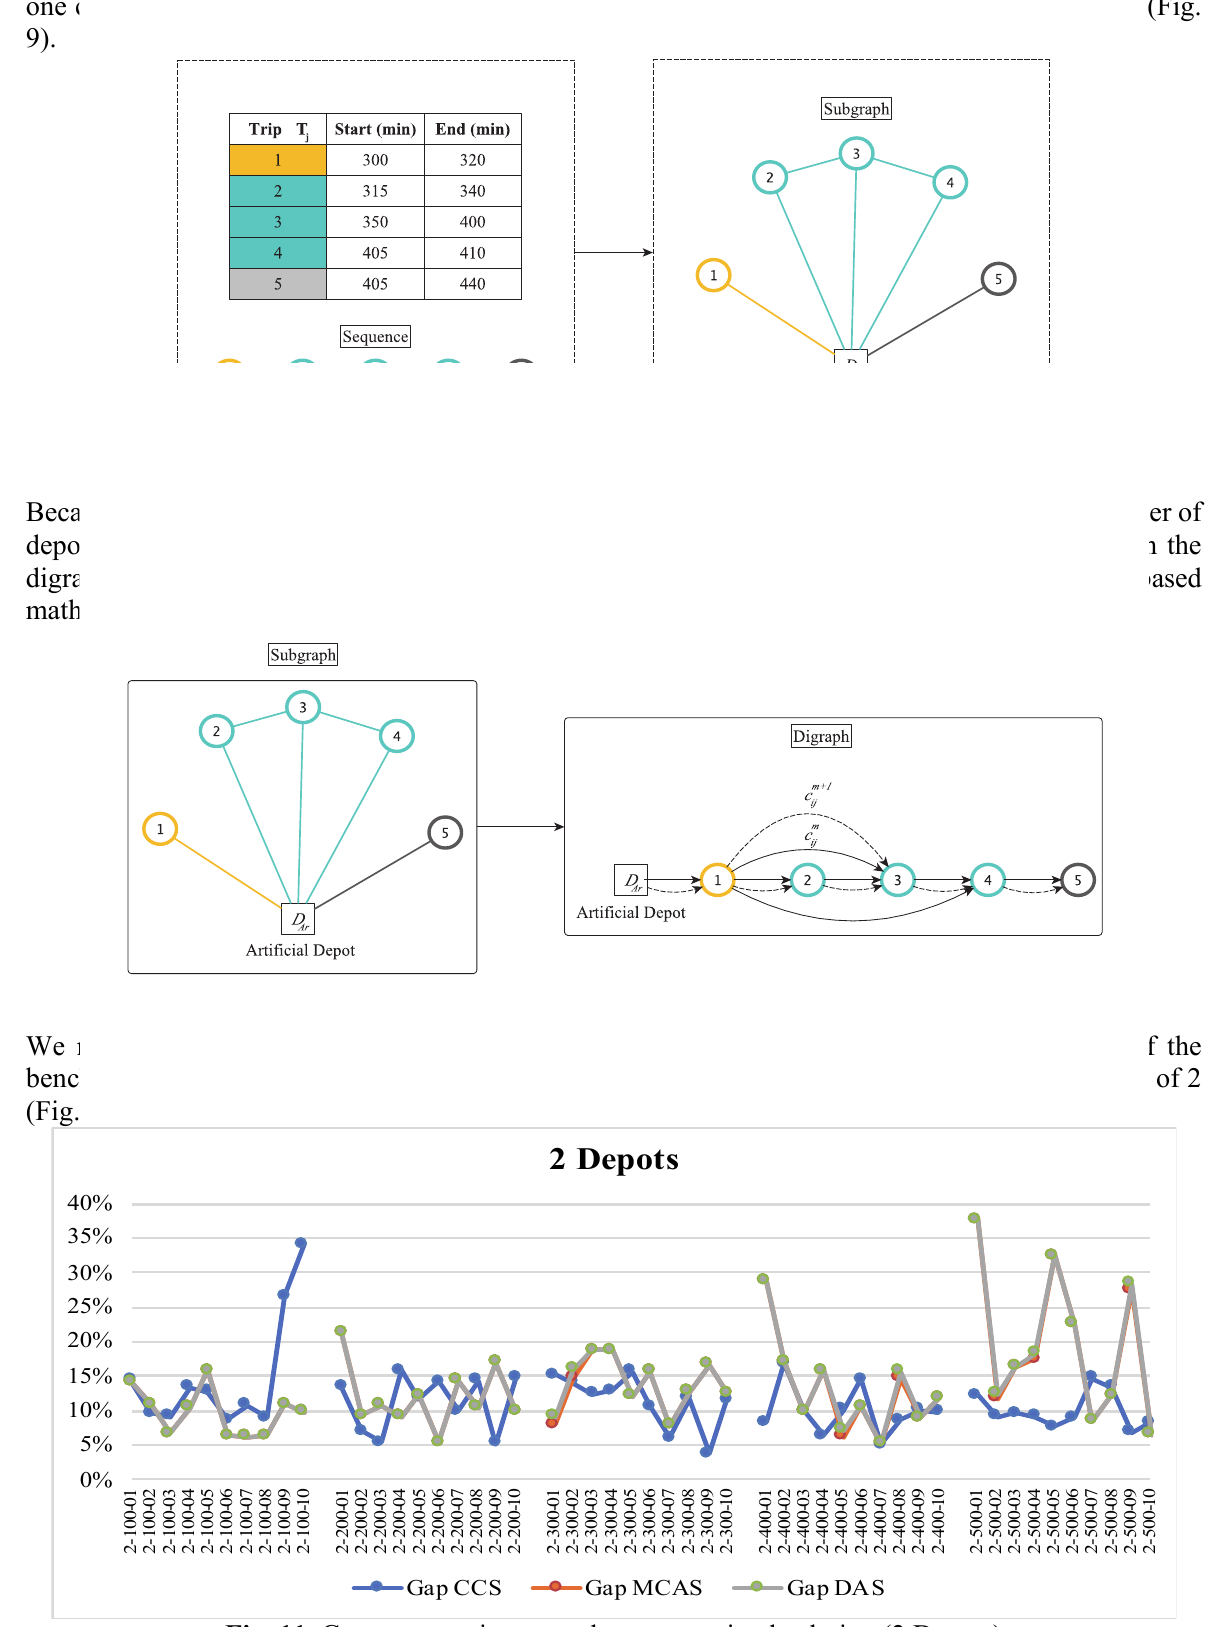
Fig. 11. Gap constructive procedures vs. optimal solution (2